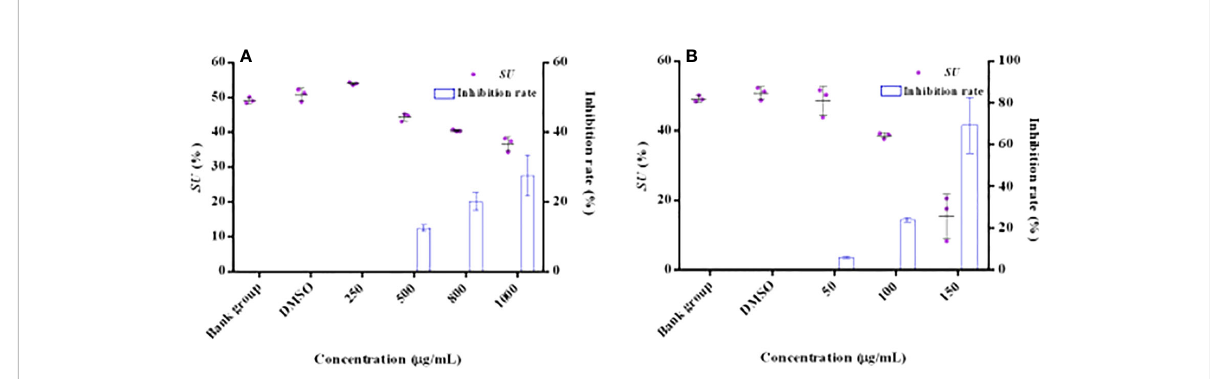
FIGURE 4 The effects of QSIs on the content of siderophore in PAO1. The in fl uence and inhibition rates (%) of hordenine on the siderophore amount (A) ; The in fl uence and inhibition rates (%) of HMMN on the siderophore amount (B) .